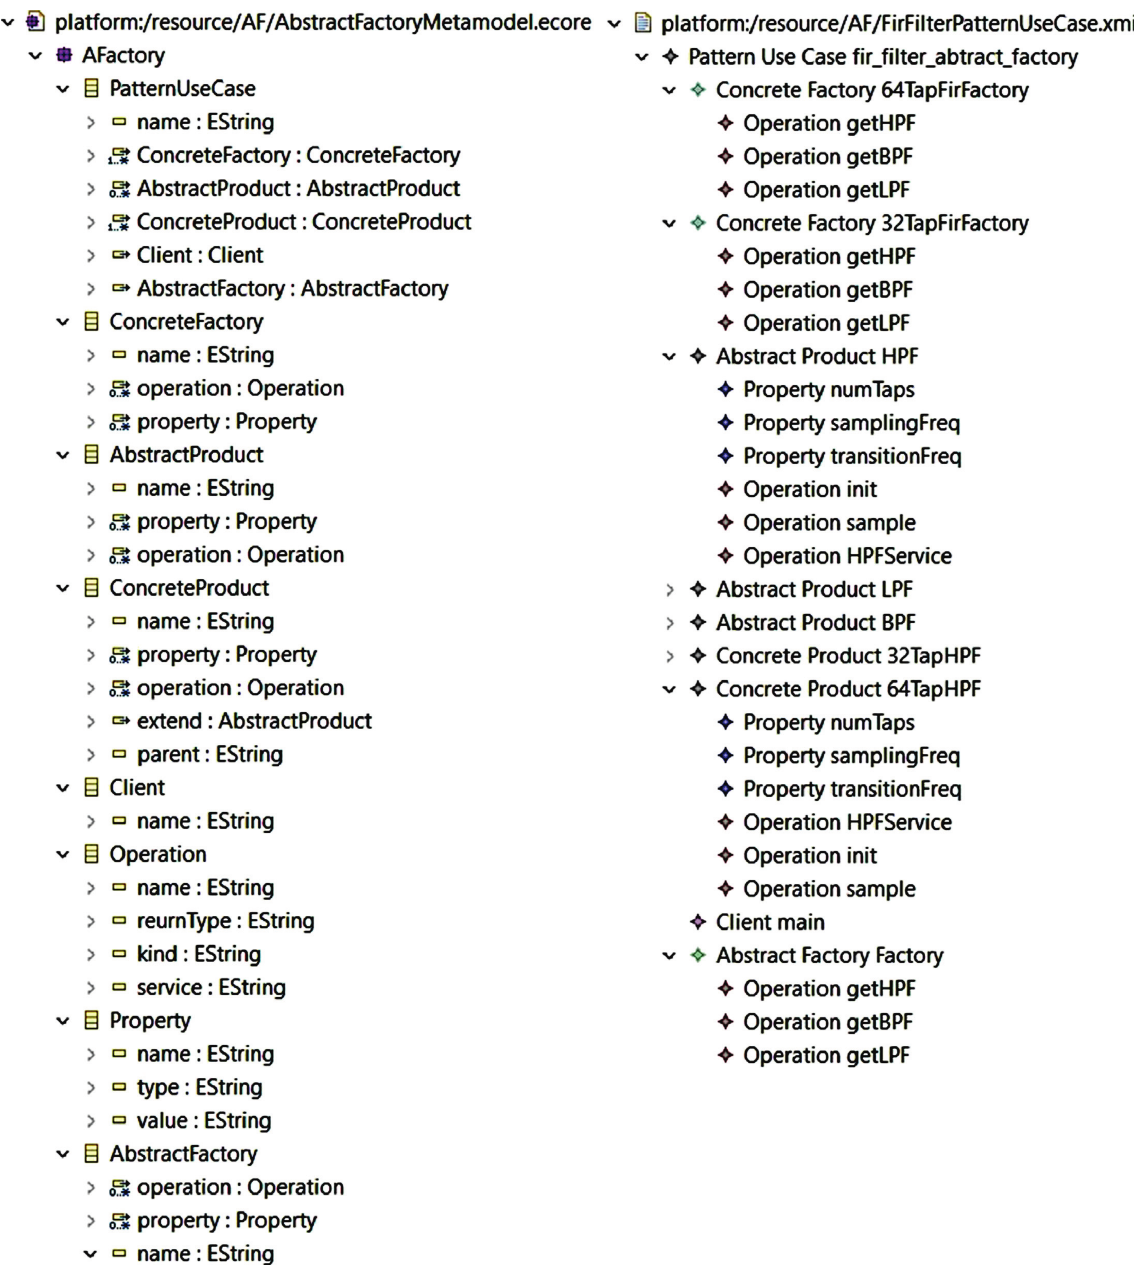
Figure 29: Abstract factory metamodel (left) and instantiated FIR filter model